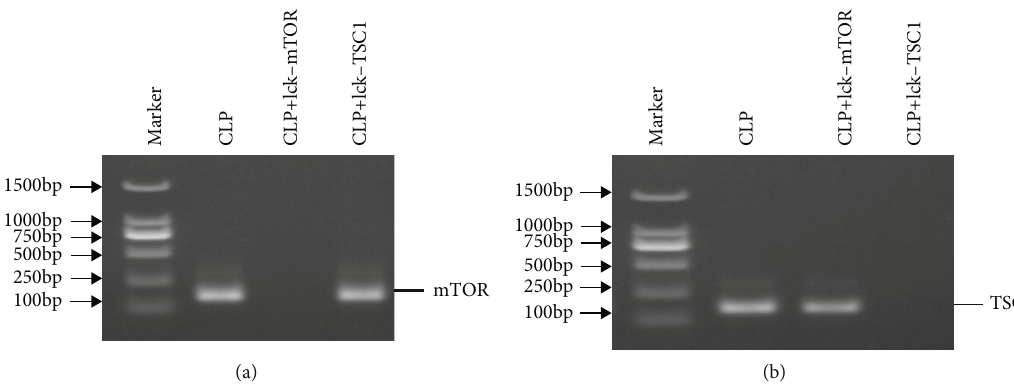
Figure 1: mTOR and TSC1 mRNA expression in CD4 + T cells in CLP, lck-mTOR, and lck-TSC1 mice. Agarose gel electrophoresis of colony PCR (a) mTOR and (b) TSC1 genotyping.